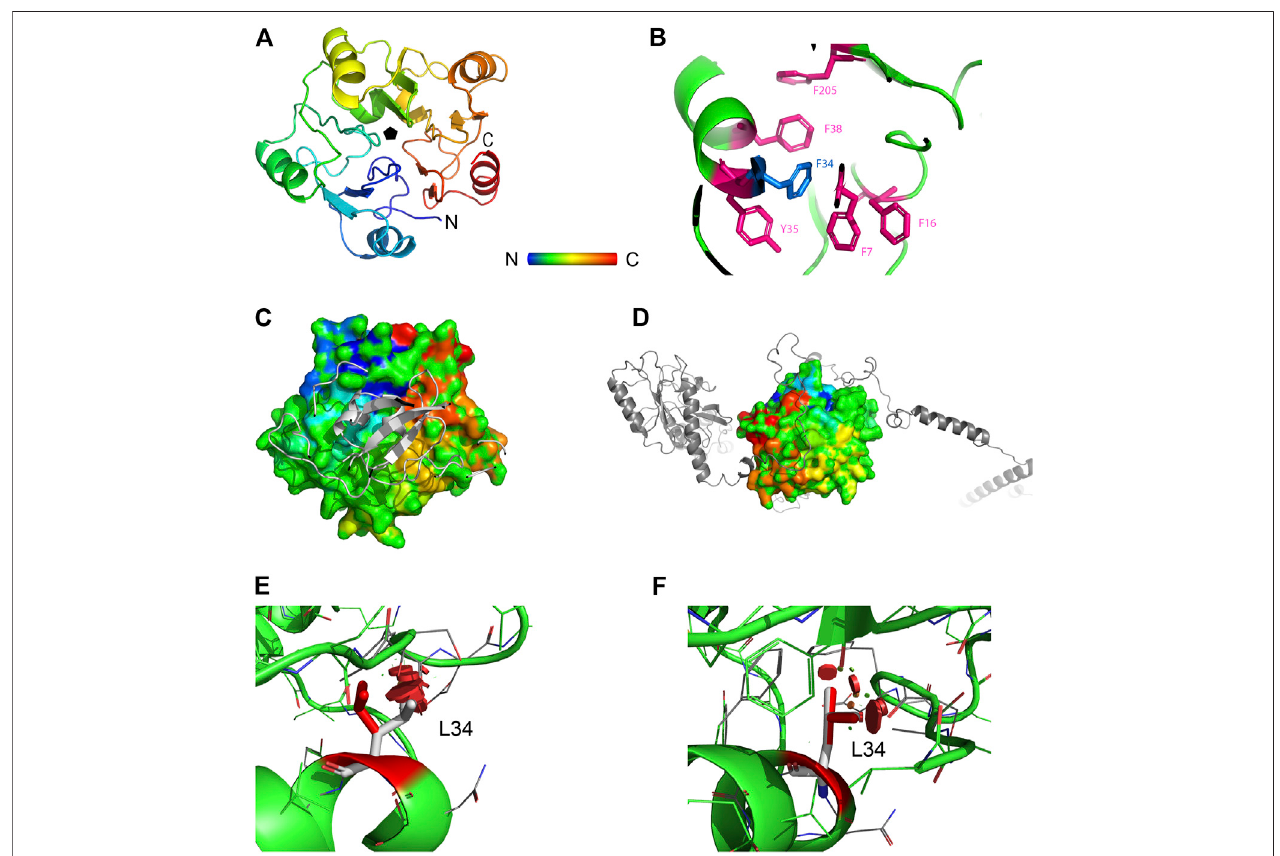
FIGURE 2 | Structural analysis of eIF6. (A) Rainbow-colored (blue: N-terminus, red: C-terminus) ribbon representation of eIF6, consisting of fi ve quasi-identical alpha/beta subdomains arrayed about a fi ve-fold axis ofpseudosymmetry. (B) Residue F34 (blue sticks) isthe core part of achain ofhydrophobic interactionsmediated by a cluster of fi ve aromatic residues (F7, F16, F34, F38, and Y35) belonging to the N-terminal domain and one, F205, belonging to the C-terminal domain (pink sticks). (C) Surface representation of eIF6 interacting with ribosomal protein L23 (gray ribbon). (D) Surface representation of eIF6 interacting with ribosomal protein GTPBP4 (gray ribbon). (E,F) Effect of the F34L mutation: red solid disks represent clashes between the two rotamers of L34 and neighboring